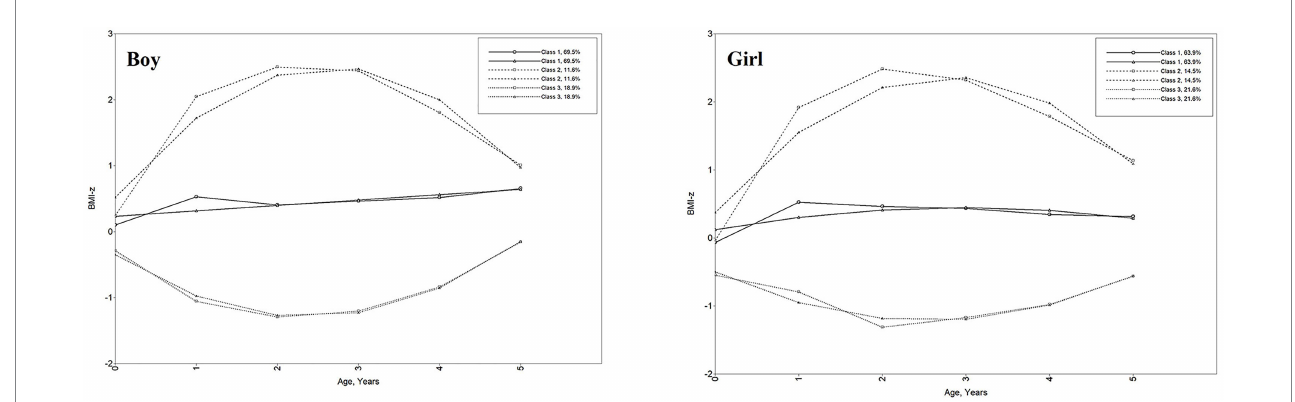
FIGURE 2 Child BMI-z growth trajectories from birth to 5 years. Class 1: moderate-BMI-z trajectory, Class 2: high-BMI-z trajectory, Class 3: low-BMI-z trajectory. Line of circle symbol represents sample means; line of triangle symbol represents estimated